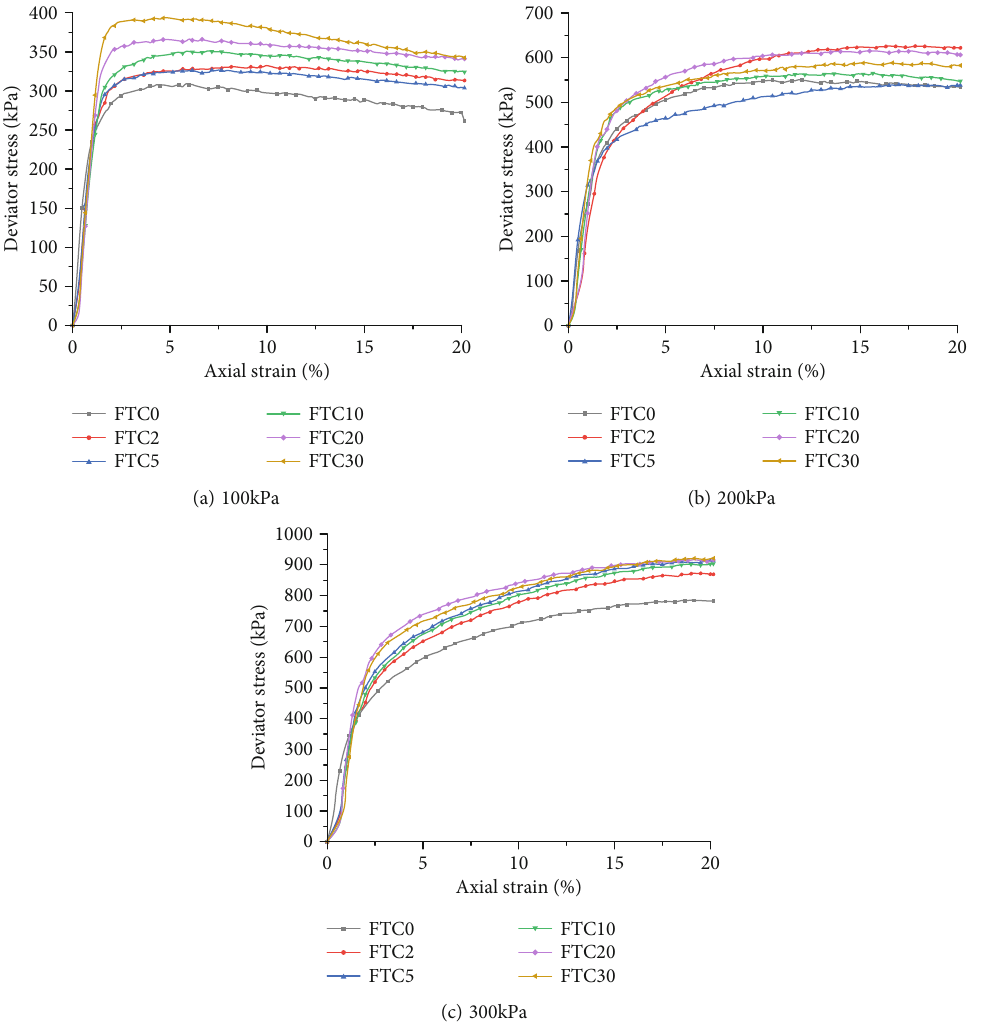
Figure 5: Stress-strain curve of basalt fi ber